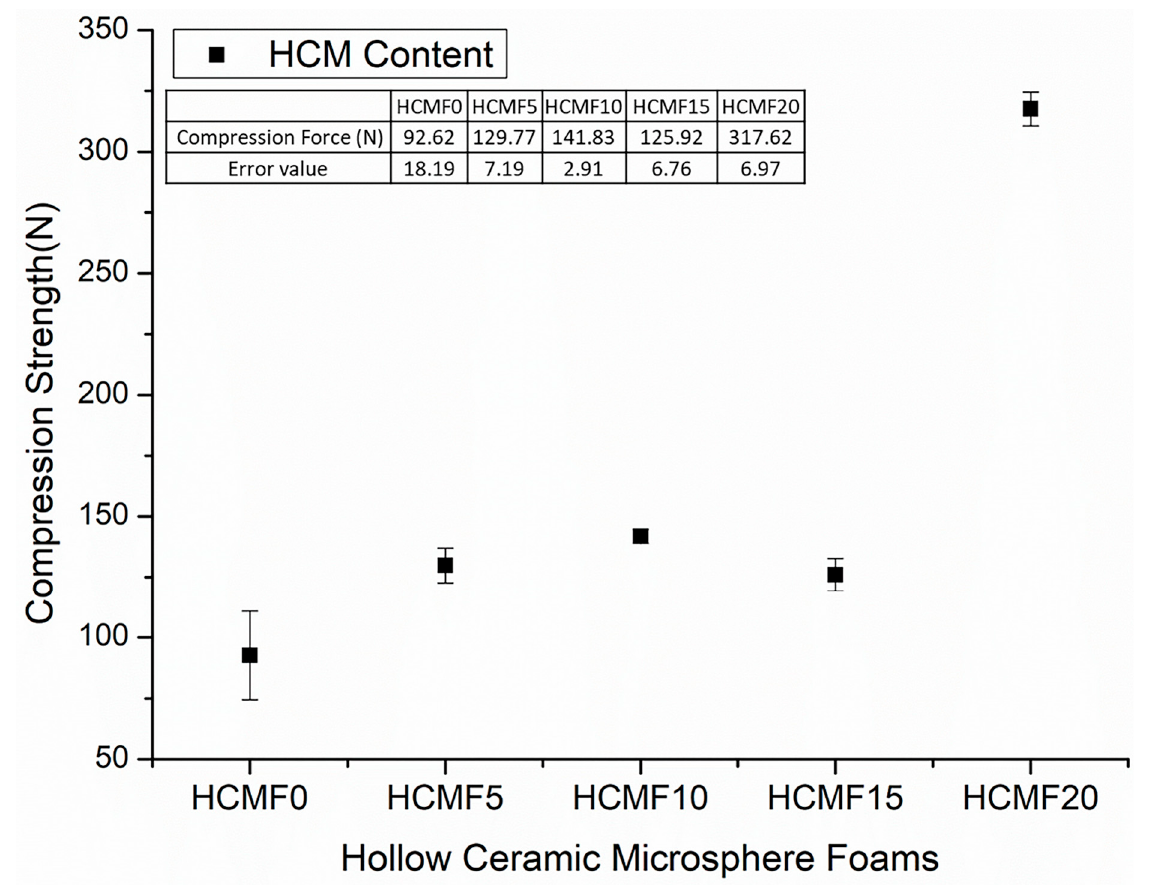
Figure 8. Compression force of HCMF composites as related to the HCM content.